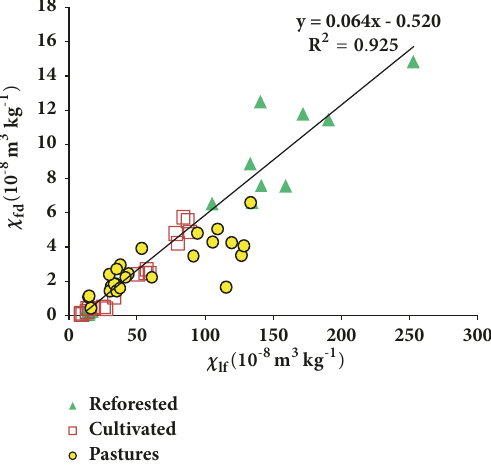
important as shown in Tables 2-4. In the reforested soils, 𝜒 × 10 −8 m 3 kg −1 with a mean fd ranges from 0.08 and 14.85 −8 3 −1 m kg , for the cultivated soils, 𝜒 fd varied of 6.35 × 10 between 0.08 to 5.73 × 10 −8 m 3 kg −1 with a mean value of 1.98 × 10 −8 m 3 kg −1 and 0.43 to 6.6 × 10 −8 m 3 kg −1 with an average −8 3 −1 m kg for the pastures land. Low values of of 2.51 × 10 𝜒 fd probably indicate beginning pedogenetic formation of magnetic particles in soils.